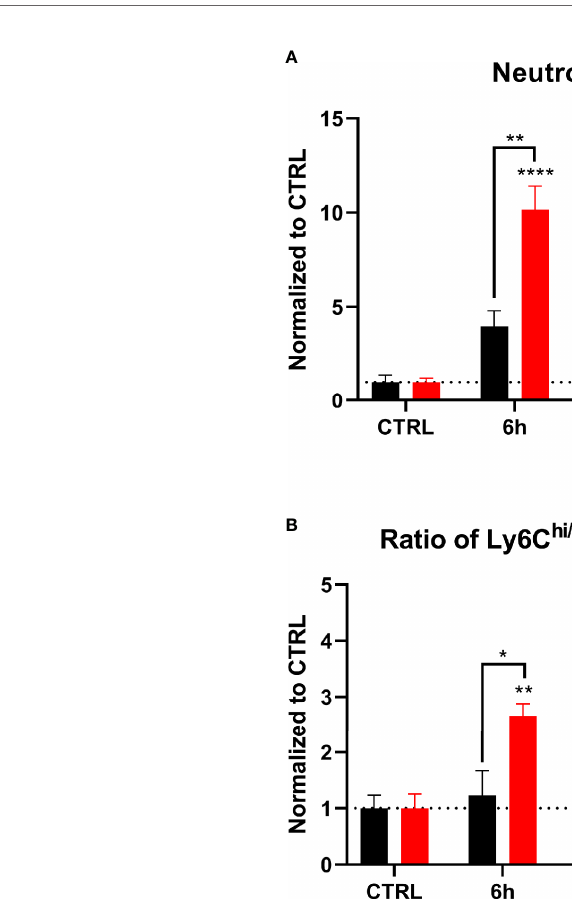
FIGURE 7 | CyTOF analysis of immune population in the muscle of lean and obese mice after trauma. Baseline-corrected (ratio) timelapse for neutrophils (A) and the ratio of Ly6C hi/lo monocytes (B) . Statistics: two-way ANOVA with an uncorrected Fisher ’ s LSD test as follow-up was used to compare the level to the respective CTRL, signi fi cance indicators are displayed directly above the bar; unpaired two-tailed Student ’ s t -test was used for comparison of lean and obese mice at a speci fi c time point, signi fi cance indicators are displayed next to the connector line. * indicates p ≤ 0.05, ** indicates p ≤ 0.01, *** indicates p ≤ 0.001, p**** indicates p ≤ 0.0001. Sample sizes: LFD CTRL = 4, LFD 6 h = 6, LFD 72 h = 6, LFD 192 h = 4, HFD CTRL = 5, HFD 6 h = 4, HFD 72 h = 4, HFD 192 h = 4. Data are displayed as mean ±